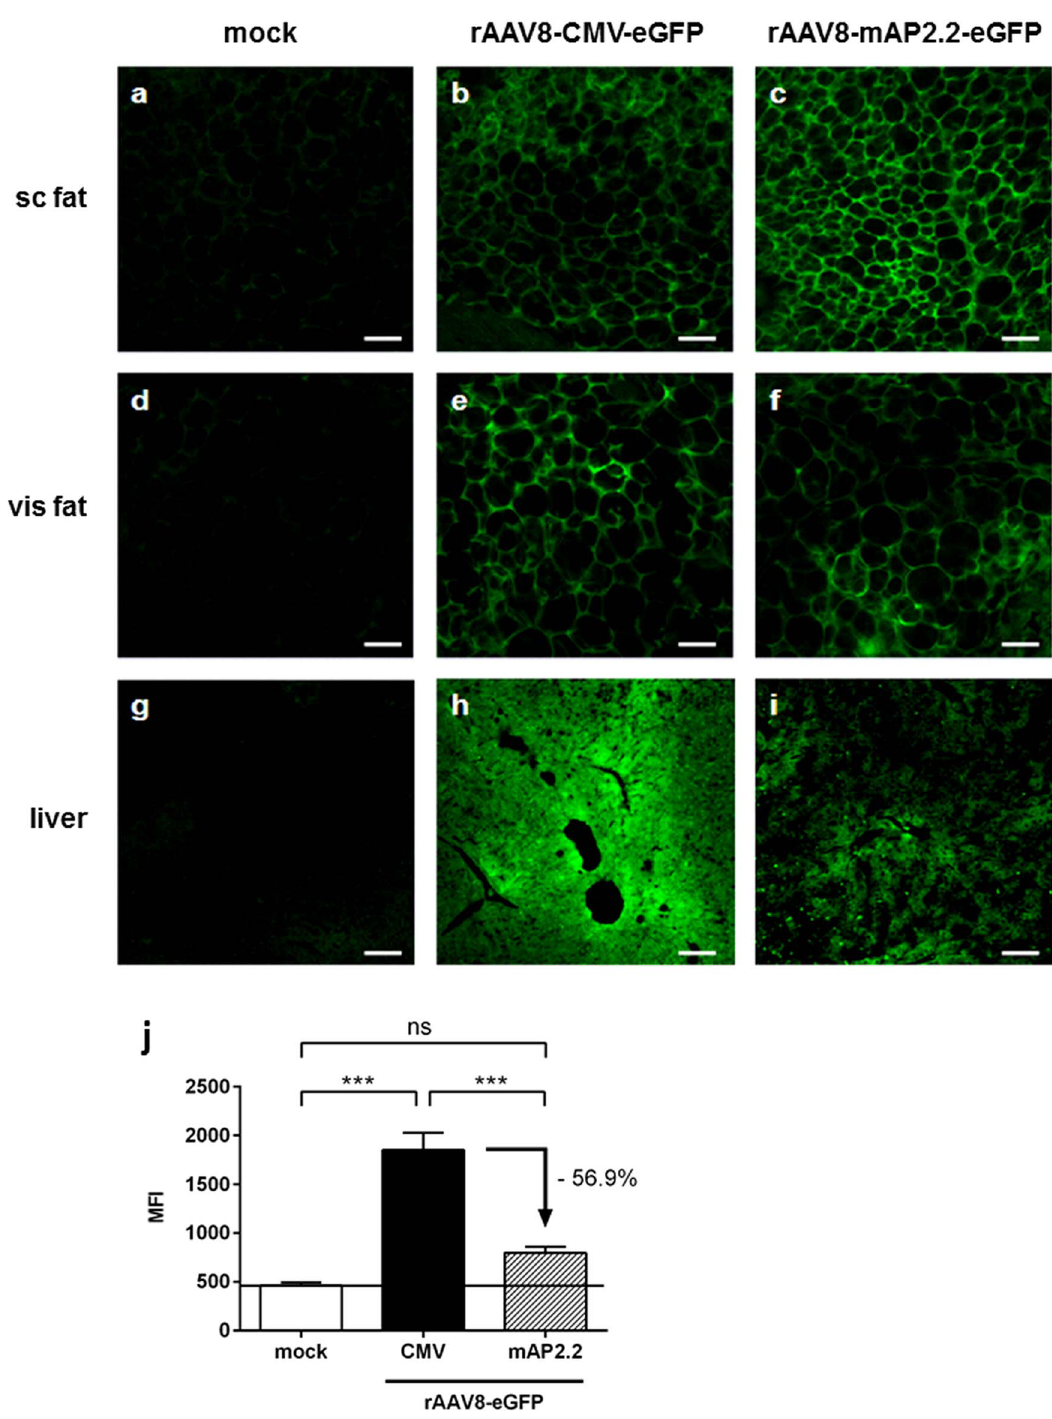
Fig. 3. Histological assessment of eGFP expression following systemic application of rAAV8-CMV-eGFP and rAAV8-mAP2.2-eGFP. Five C57BL/6 mice per group were injected with 10 12 VG per animal of rAAV8-CMV-eGFP, rAAV8-mAP2.2-eGFP or PBS as a mock control via the tail vein. Three weeks post-injection, mice were sacrificed and tissue samples from subcutaneous (sc) fat, visceral (vis) fat and liver were taken and rapidly frozen in liquid nitrogen. Cryosections of liver and adipose tissues were evaluated for eGFP expression by confocal fluorescence microscopy using direct imaging of tissue slices. (a–i) Representative images are shown for sc fat (a–c), vis fat (d–f) and liver (g–i). (a,d,g: mock; b,e,h: rAAV8-CMV-eGFP; c,f,i: rAAV8-mAP2.2-eGFP),